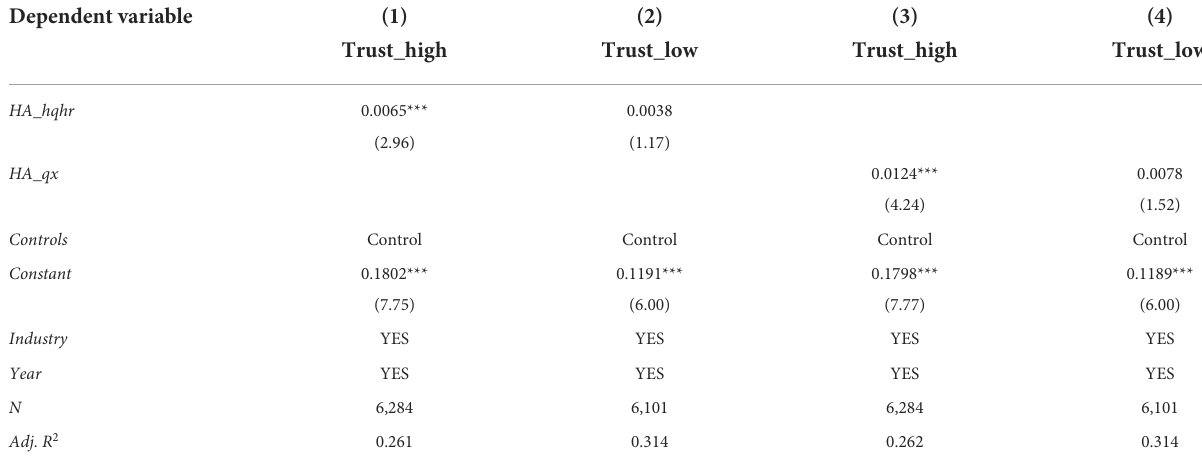
TABLE 9 The moderating effect of social trust (H5).